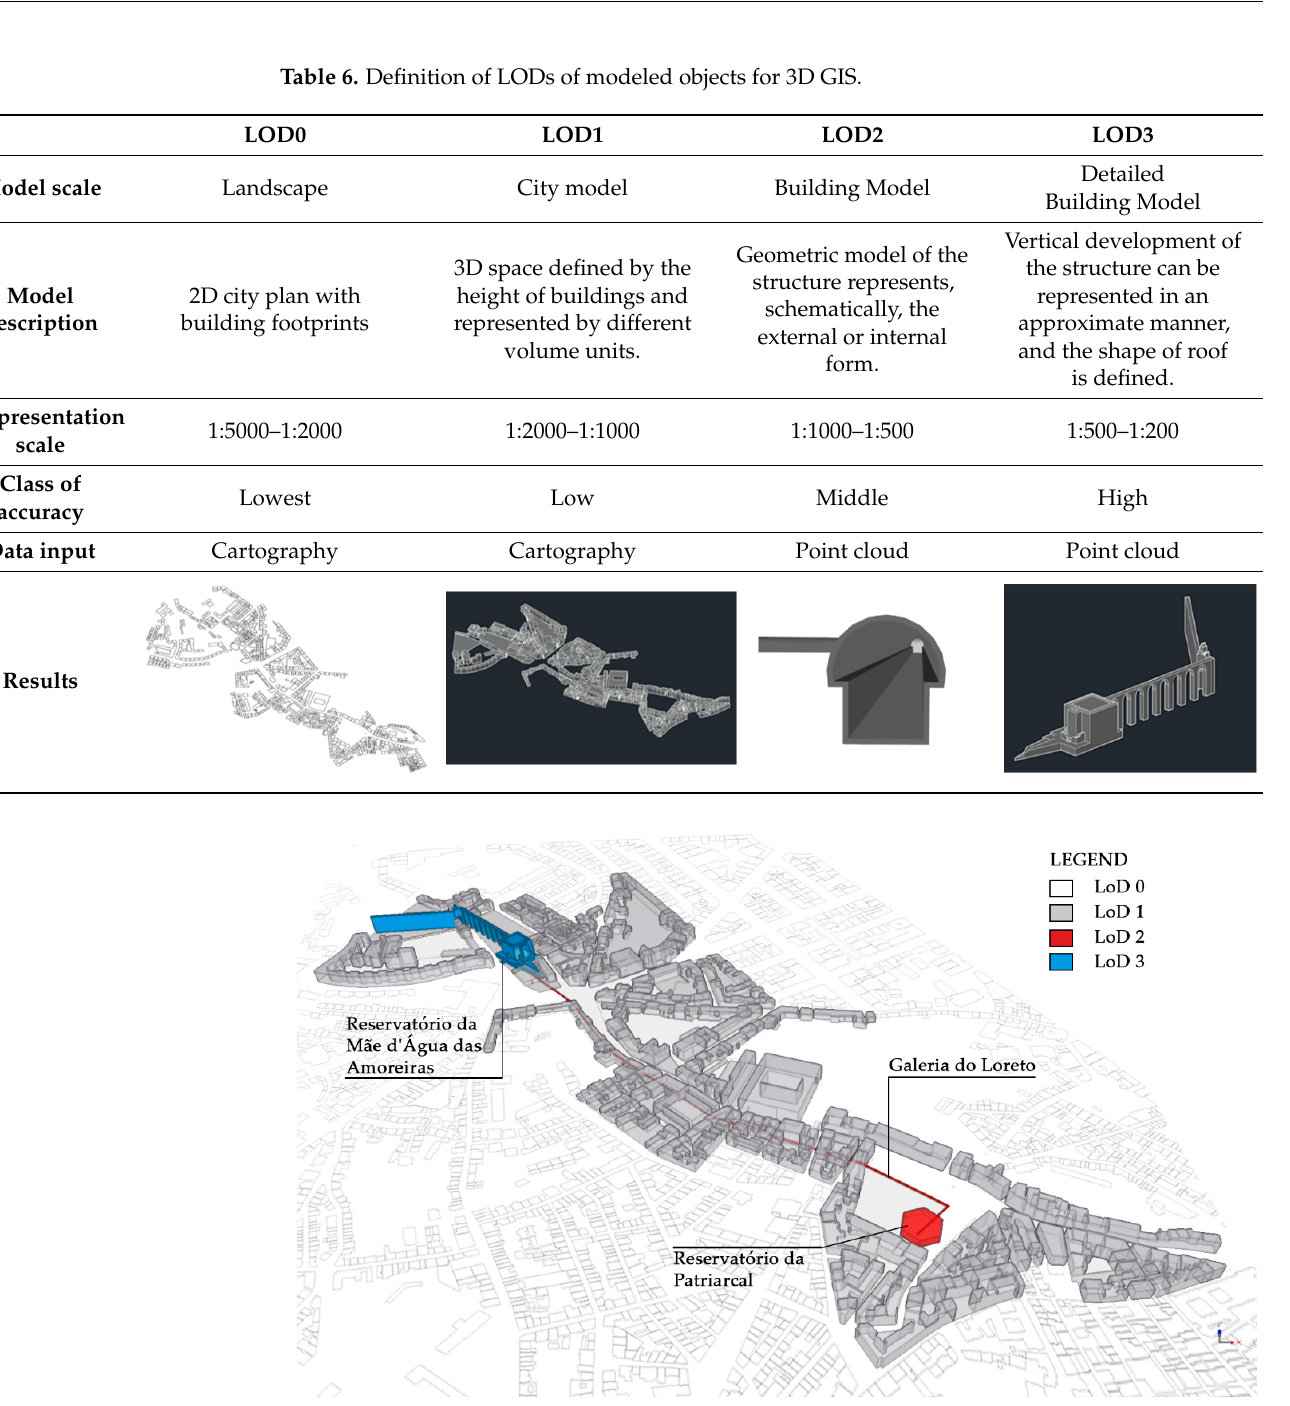
Figure 12. Representation of 3D model according to LOD classification.